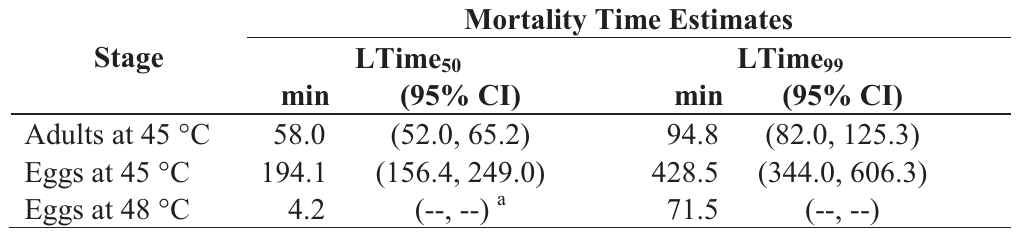
Table 2. Lethal time estimates for 50 and 99% mortality of bed bugs exposed to temperatures below the lethal temperature of 48.3 °C for adults and 54.8 °C for